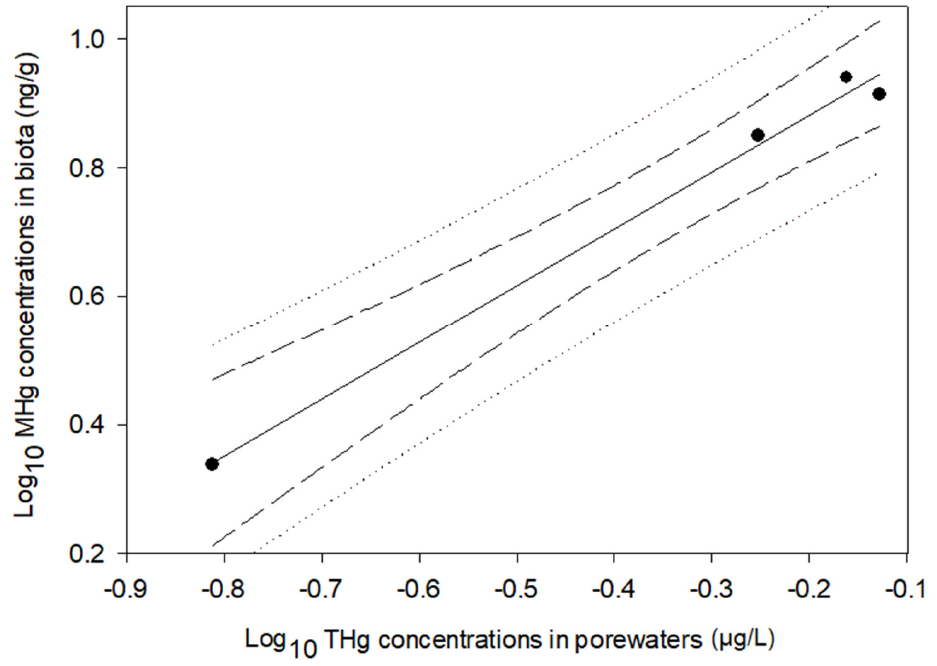
Figure 6. The relationship between the mercury concentrations in sediment porewaters and the mercury bioaccumulation in biofilm. The solid line, the area of dashed lines, and the area of dotted lines indicate the fit of these data, 95% CIs, and 95% prediction limits, respectively.